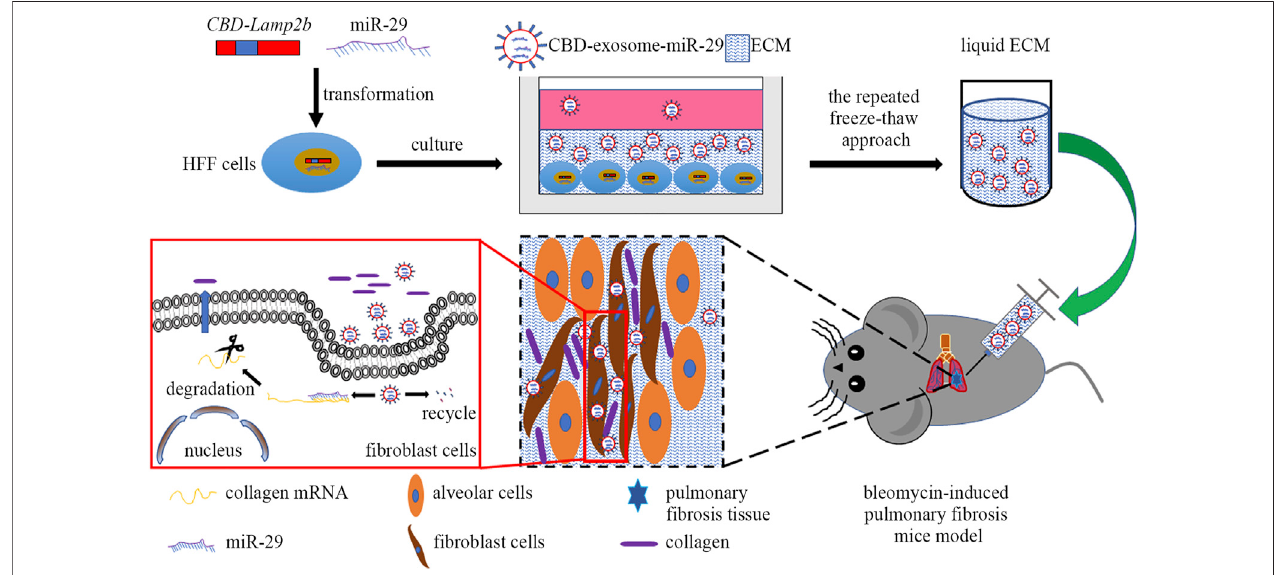
FIGURE 1| The scheme of this study includes four main steps: 1) construction ofHFF cell lines thatstably expressing CBD-Lamp2b and miR-29; 2) enrichmentof CBD-exosomes in ECM; 3) production of liquid ECM; 4) treatment of pulmonary fi brosis mice with mi29-Exo-ECM biomaterial.